Question: What form of chart is displayed?
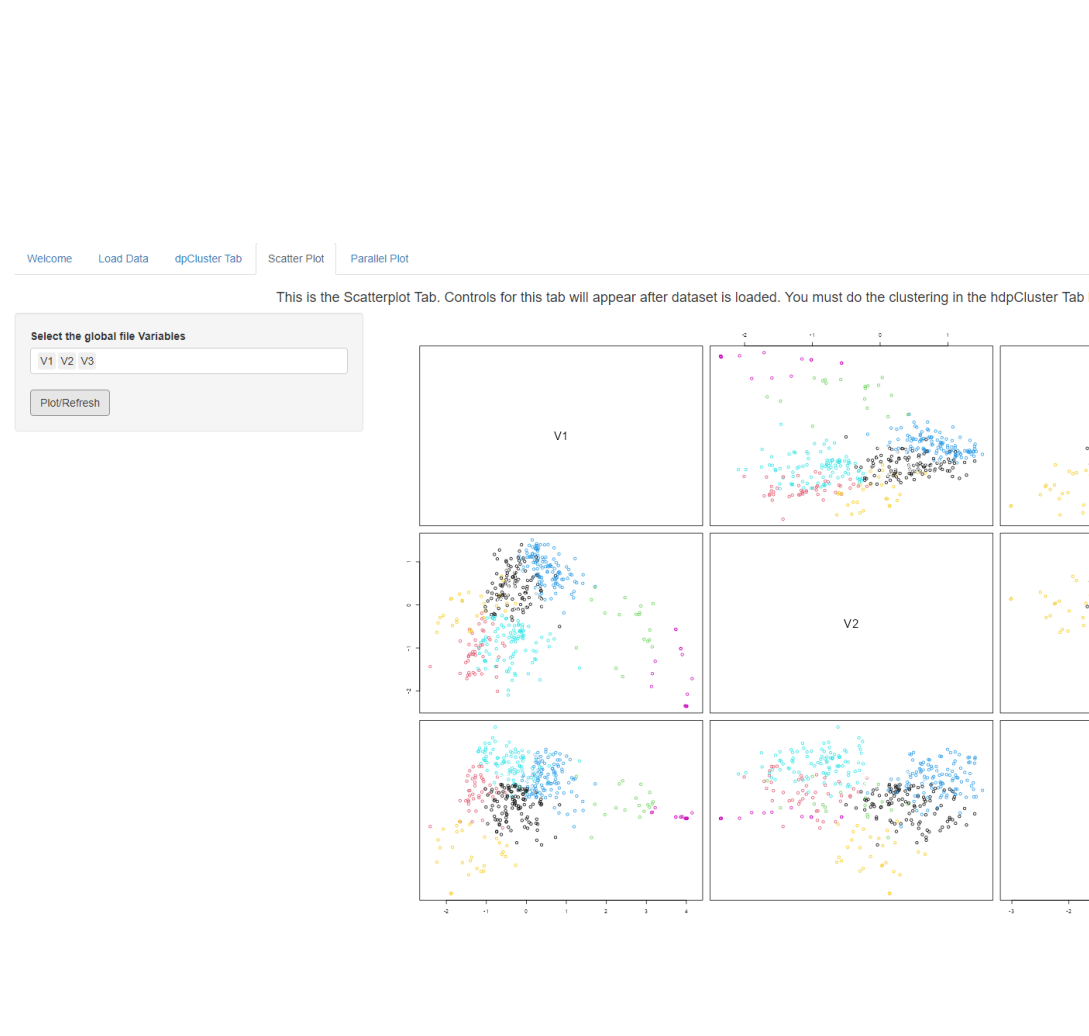
Answer: scatter